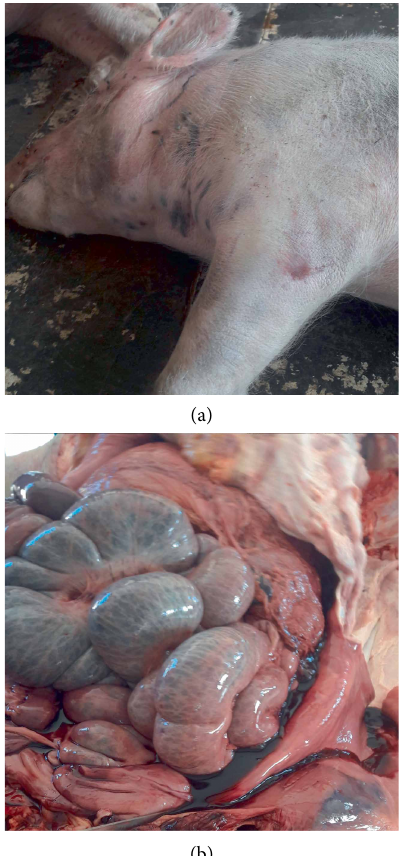
Figure 4: Multifocal ecchymotic skin hemorrhages on the neck (a); frank nonclotting blood in the peritoneal cavity (b).